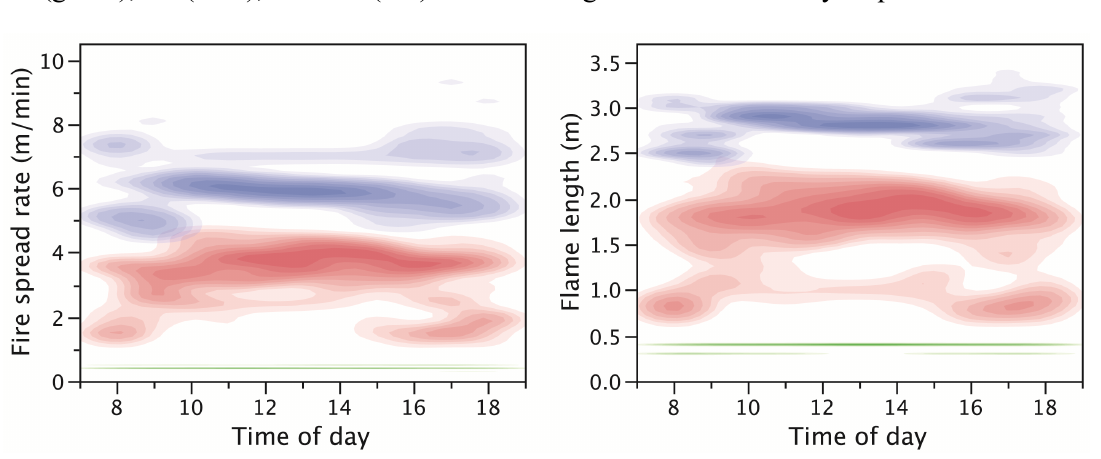
Figure 4. Non-parametric bivariate density of simulated fire behavior characteristics for CL (green), PP (blue), and BA (red) stands during the selected 10-day